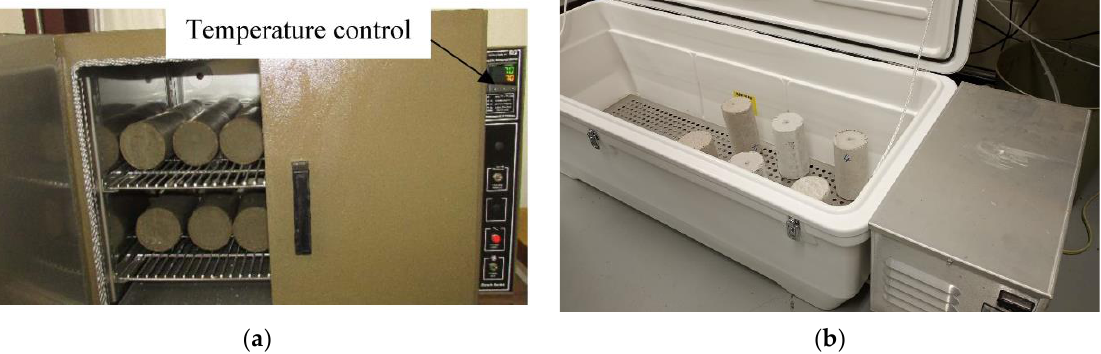
Figure 4. Temperature control equipment. ( a ) Temperature control ovens. ( b ) Freeze–thaw testing machine.